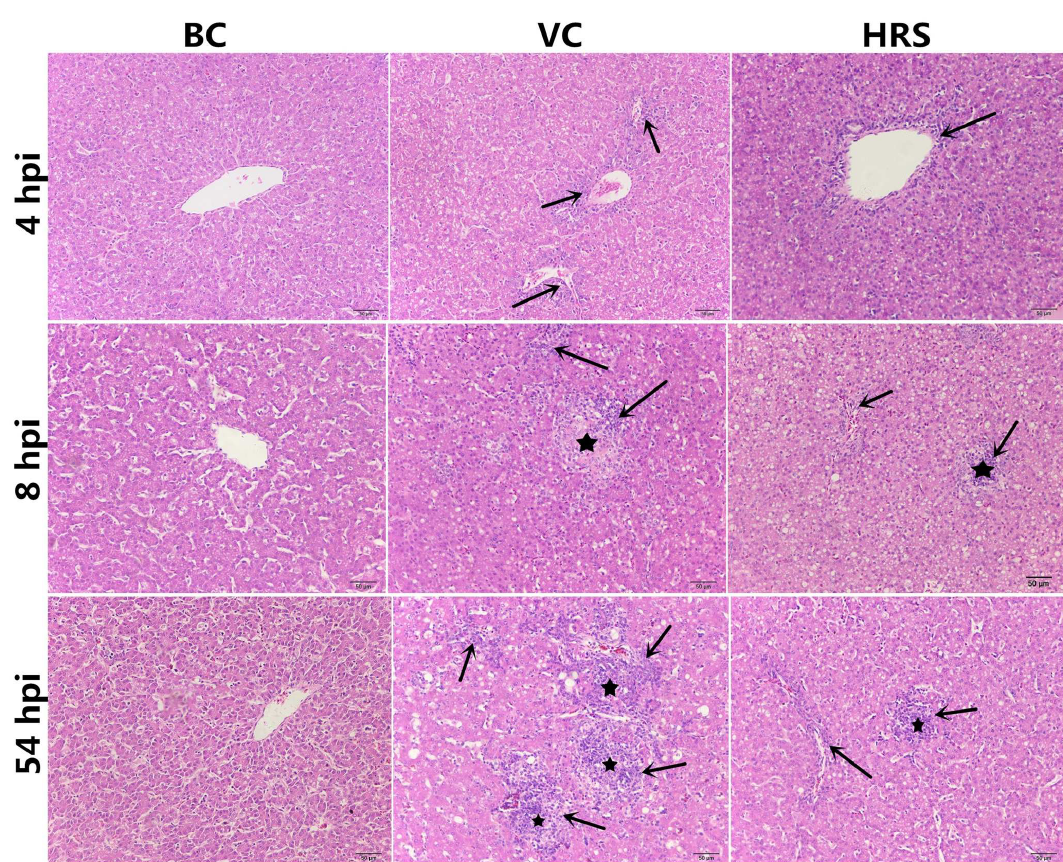
Fig 1. Liver histological changes of each group at 4 hpi, 8 hpi and 54 hpi (hpi: Hours Post-Injection) (HE stain, × 200). Liver tissues were randomlyisolated from 5 feathers collectedfrom birds in each group at 4 hpi, 8 hpi and 54 hpi. A portion of each isolated liver tissue was instantly fixed in neutral phosphate-buffered 10% formalin solutionand stained with hematoxylin and eosin (H&E). Arrows indicate inflammatory cells and pentagrams indicatenecrosis foci.